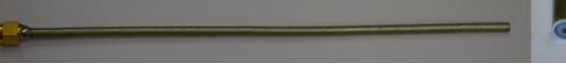
Figure 5. Photograph of the fabricated coaxial probe.